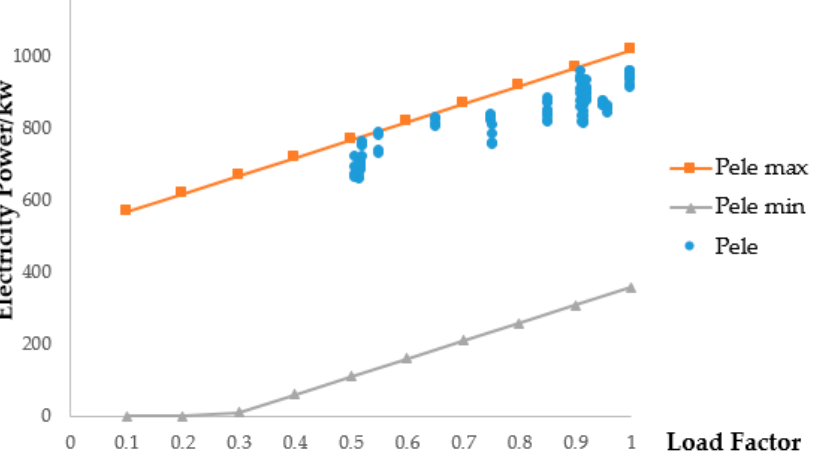
Figure 11. Multi-time scale power load-load rate operation.